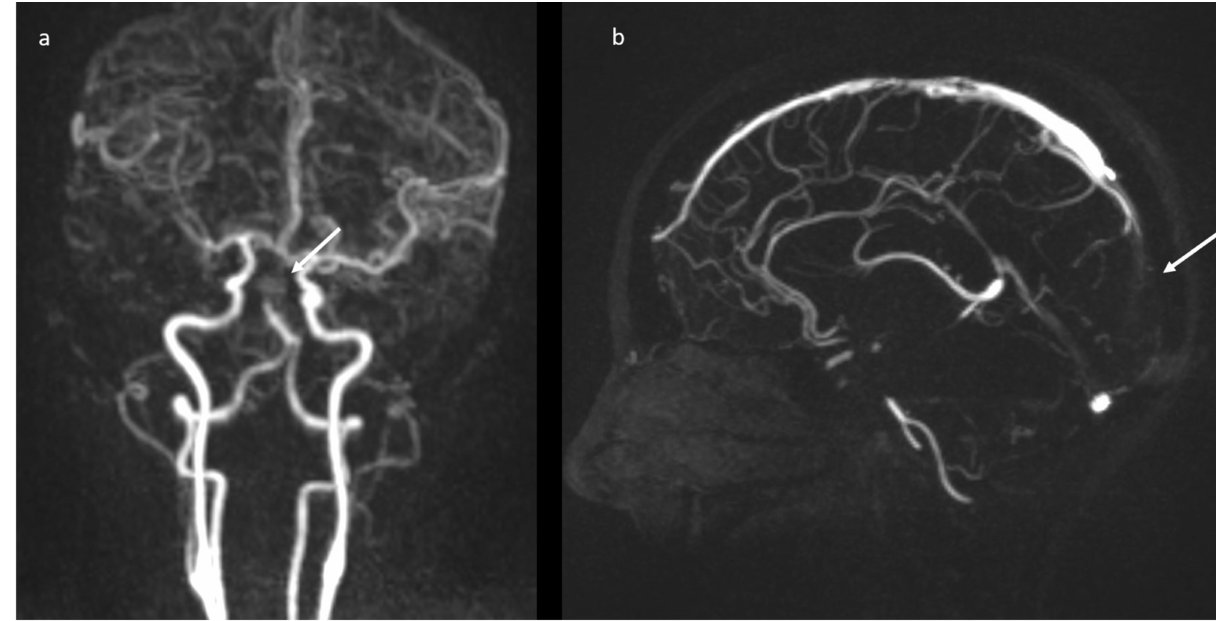
Figure 5. MR-angiography: acute basilar thrombosis associated with superior coronal ( a ) and sagittal ( b ) sinus